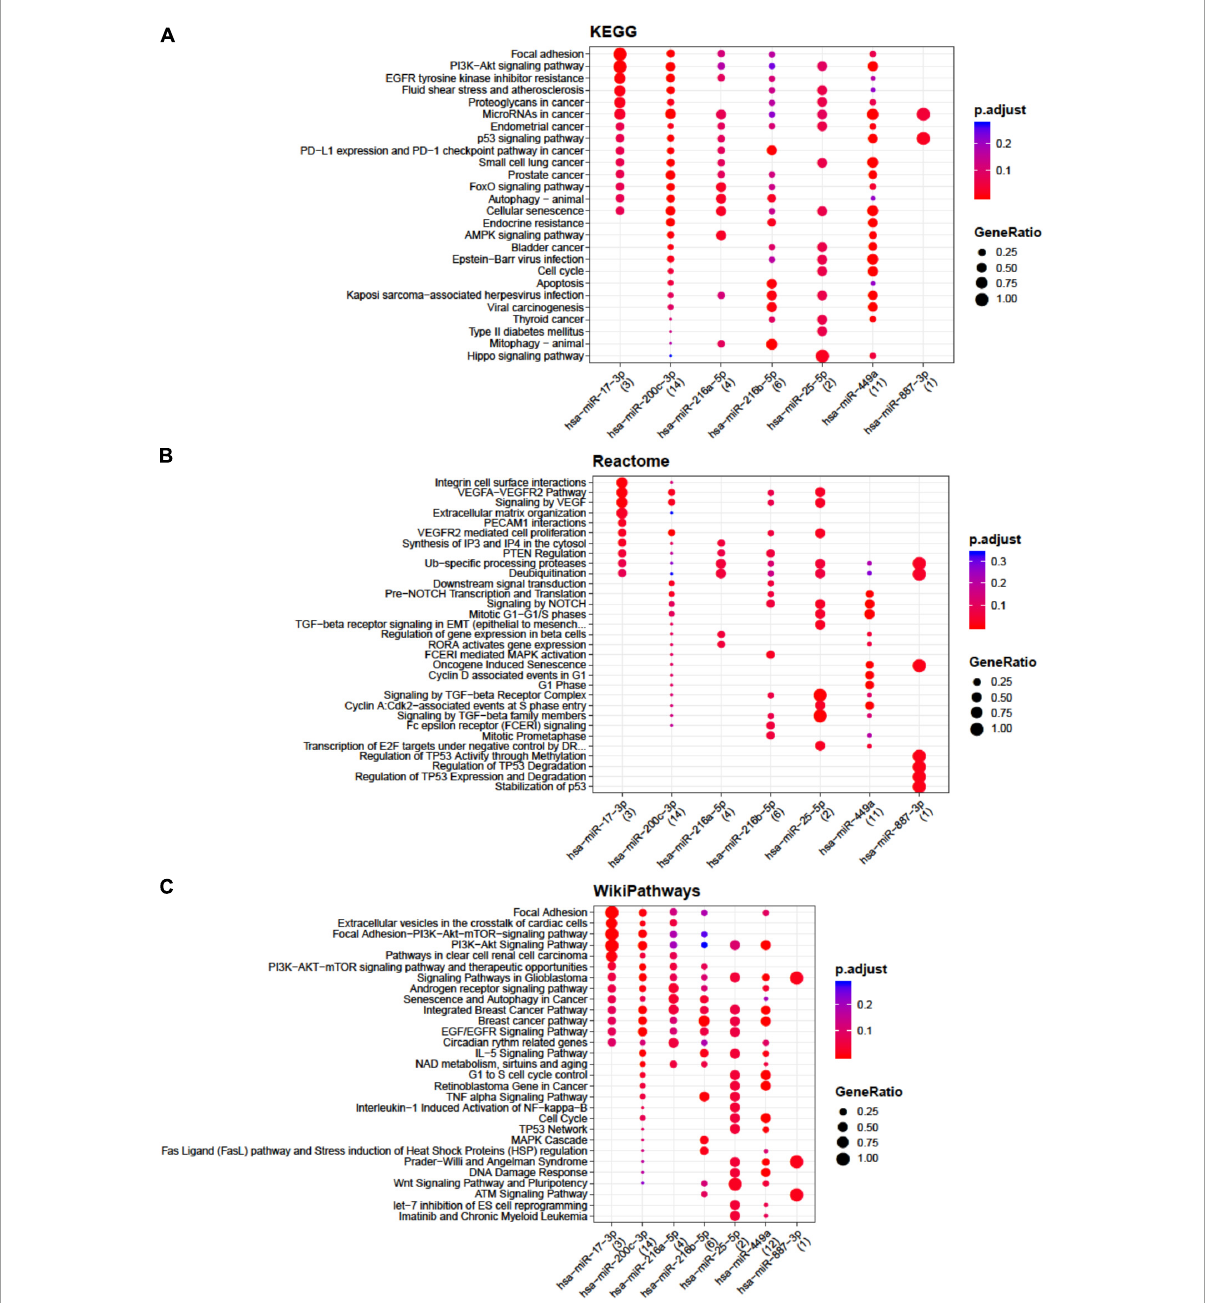
FIGURE1 Functional enrichment analysis on micro RNAs (miRNAs) selectively expressed by cartilage cells (CCs). This analysis was conducted by KEGG pathway (A) , Reactome (B) , and Wikipathway (C) . Significant pathways are listed and represented by circles colored according to the significance of the enrichment and their size is proportional to the number of target genes regulating the described signaling